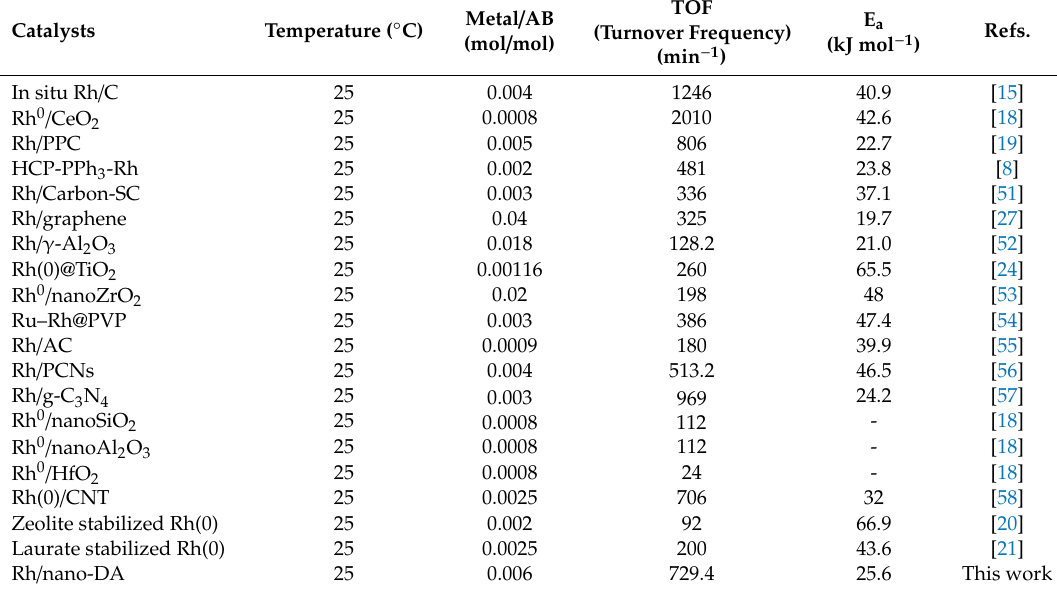
Table 1. Comparison results with the reported Rh-based catalysts toward AB